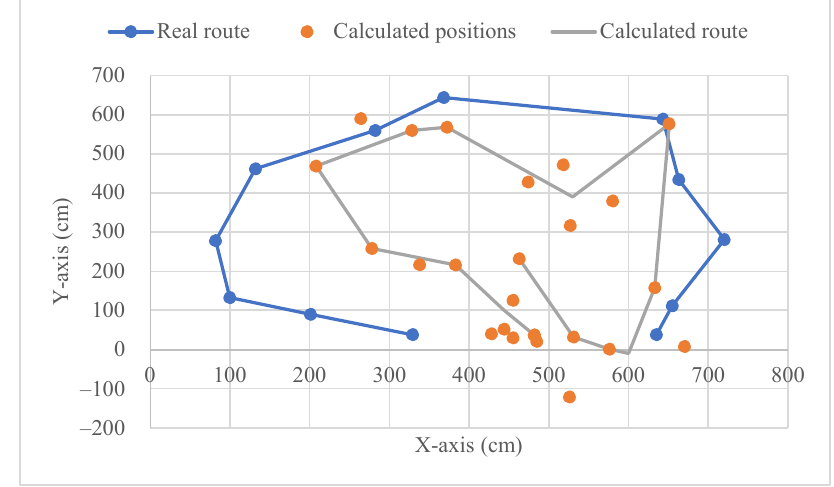
Figure 5. The result of a token positioning in dynamic.